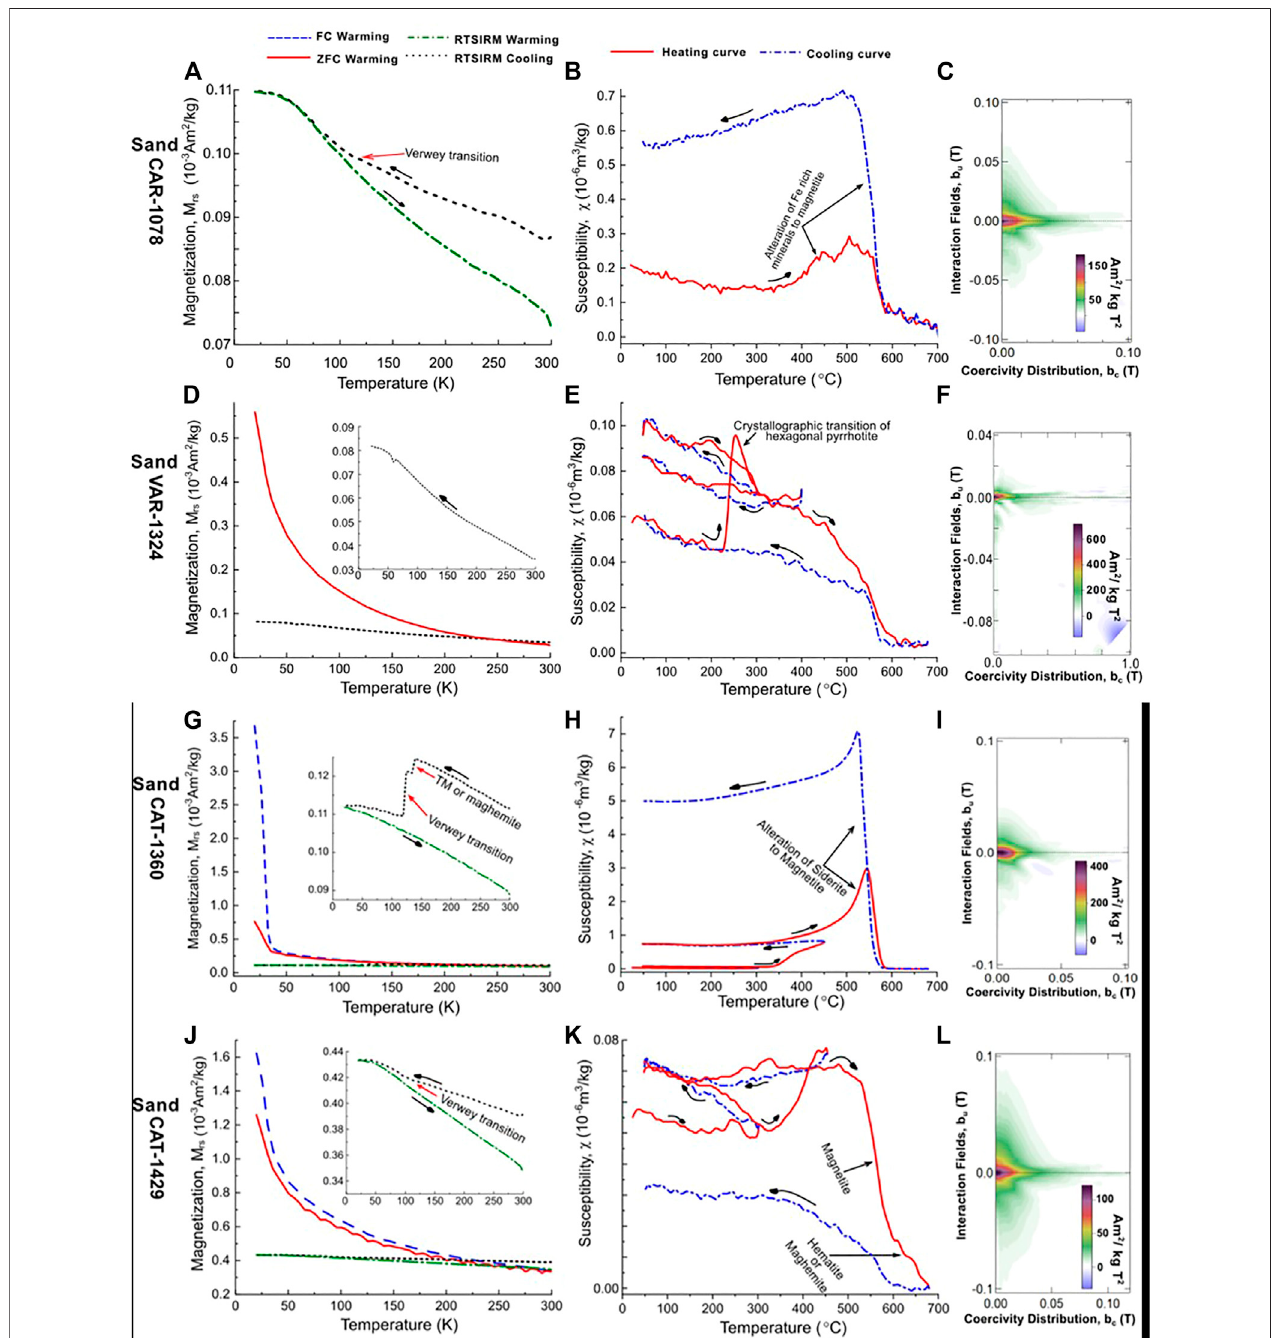
FIGURE7| ExampleresultsfromLTM,HT- χ andFORCmeasurementsforthehydrocarbonreservoirsandstonessamples;CAR-1078,VAR-1324,CAT-1360and CAT-1429areshownon (A – C) , (D – F) , (G – I) and (J – L) ,respectively.Theoilreservoirsandstonesresultssuggestthepresenceofmagnetiteandtitanomagnetite(ortheir oxidized versions), hexagonal pyrrhotite, ilmenite, hematite and potentially titanohematite. Ti-rich iron oxides are labelled as FeTiO.